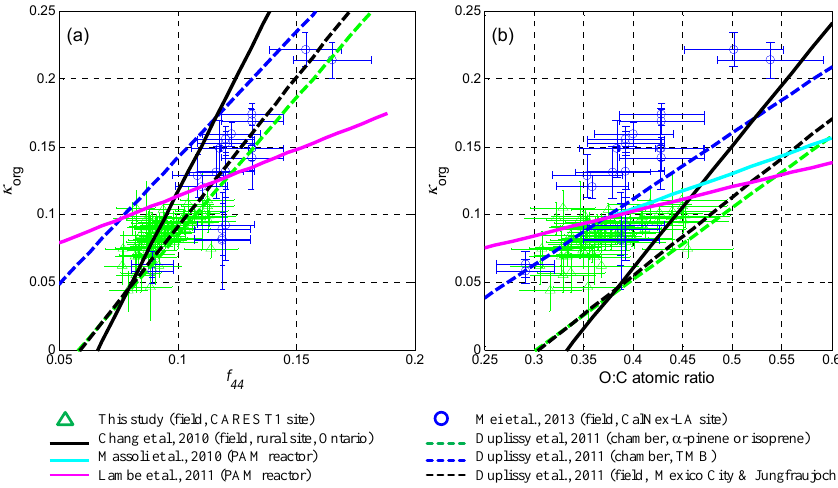
Fig. 5. Comparison with earlier studies on (a) the variation of κ org with f 44 and (b) the variation of κ org with O:C. The solid and dashed lines represent κ org derived under supersaturated and subsaturated conditions in earlier studies,